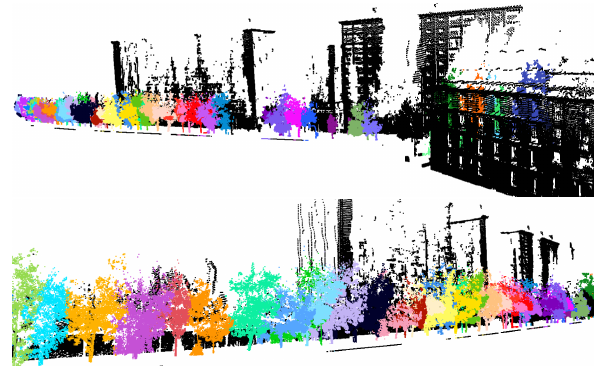
Figure 12: Individualized trees in the 3D point cloud.